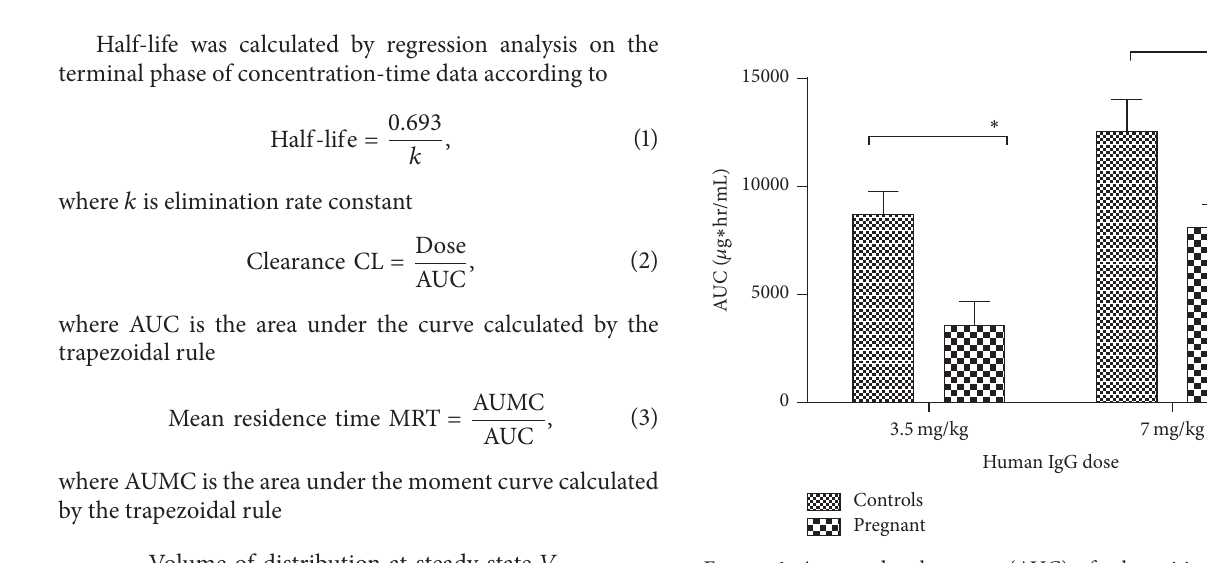
Figure 1: Area under the curve (AUC) of a hepatitis B immune globulin (HBIG) product in pregnant and nonpregnant guinea pigs. HBIG was administered intravenously at a dose 50 or 100 IU/kg ( ∼ 3.5 and 7 mg/kg) in pregnant guinea pigs at the end of gestation (GD 65 ± 2 ); age-matched nonpregnant animals served as controls. Human IgG exhibits lower AUC when it is administered at the end of pregnancy compared to nonpregnant animals, independent of dose; AUC shown as mean ± SEM, ∗ 𝑝 < 0.05 (Bonferroni post hoc